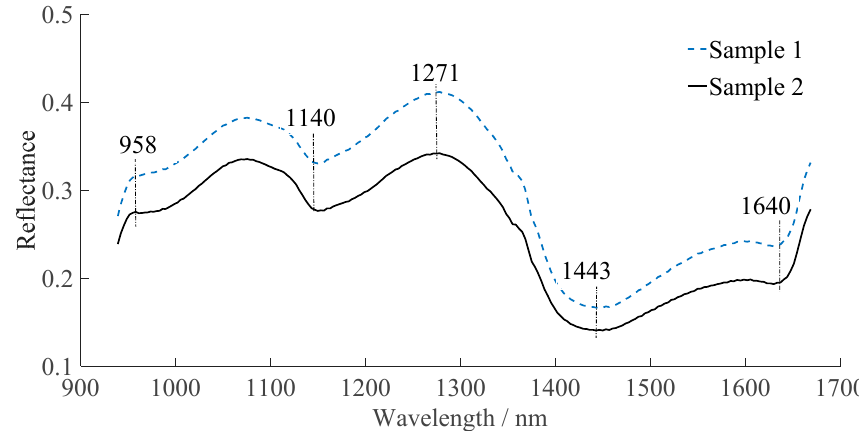
Figure 3. Reflective spectral curves.